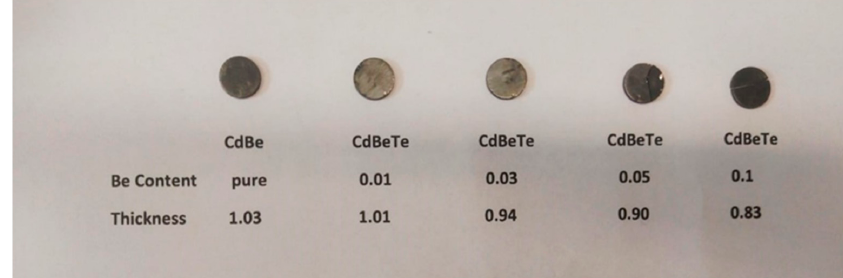
Figure 1. Prepared crystals for all the different Be content with thickness measurements.